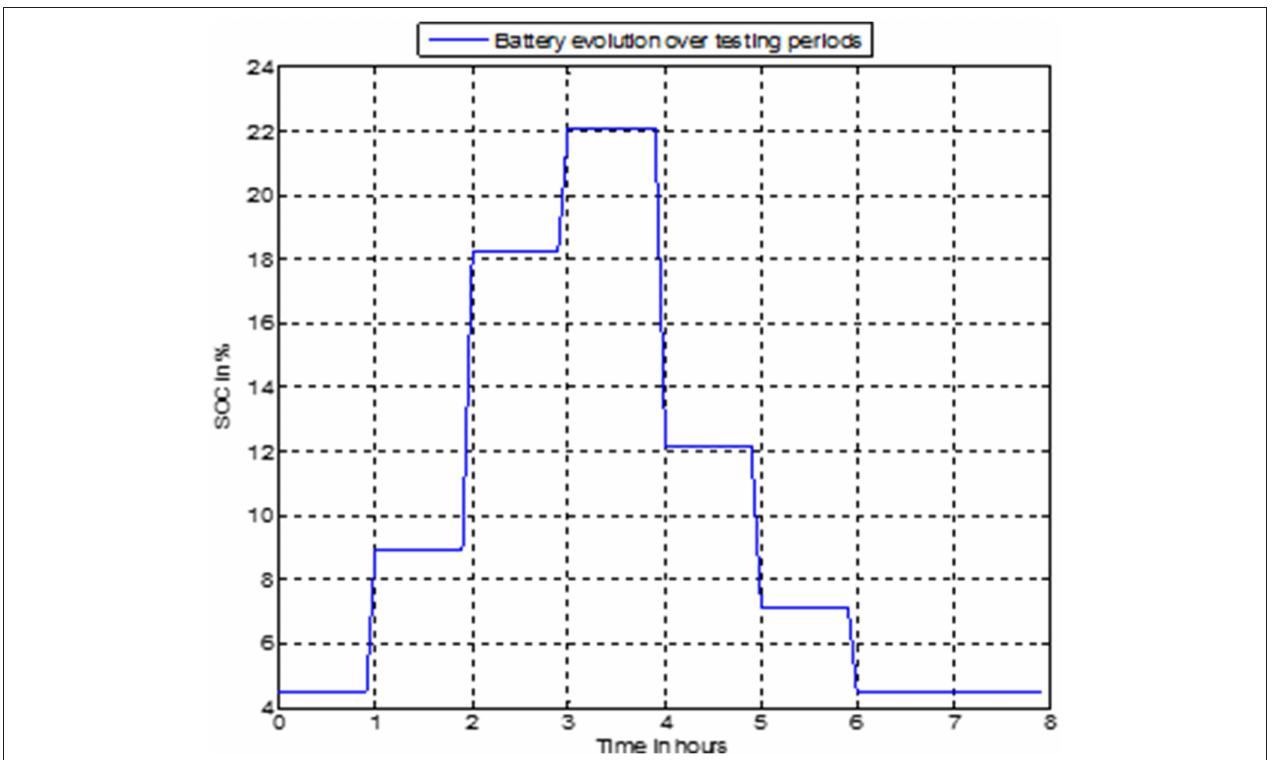
FIGURE 4 | Battery evolution over testing periods.